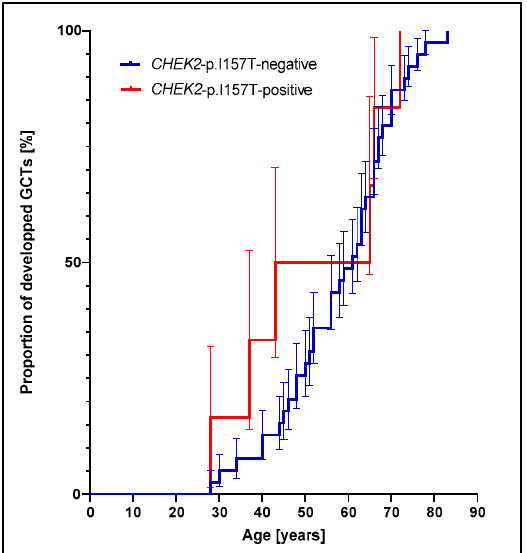
Figure 3. Kaplan–Meier estimate for age at diagnosis of GCT for CHEK2 p.I157T -positive and -negative groups. Percent ovarian GCT cases developed by specific age. Error bars: standard errors (asym- metrical).